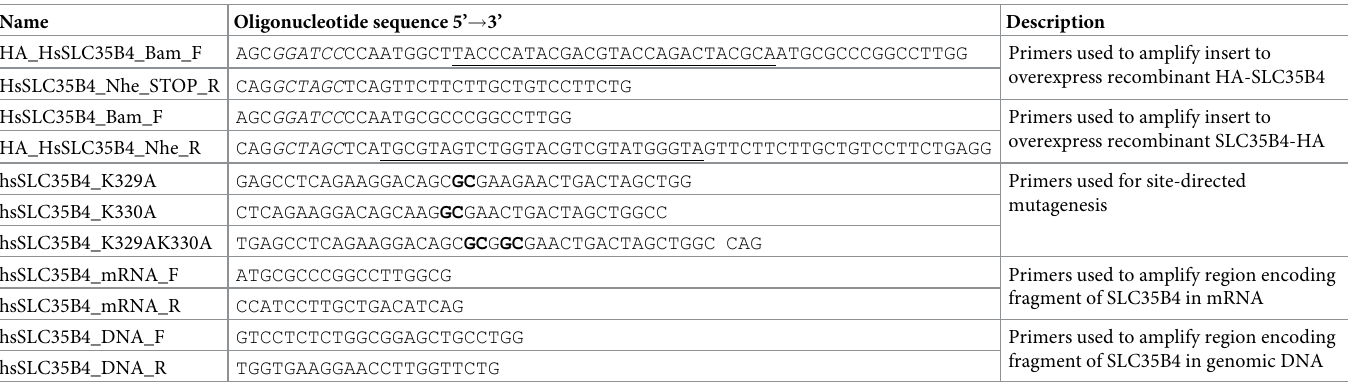
Table 1. List of primers designed and used in this study. Name